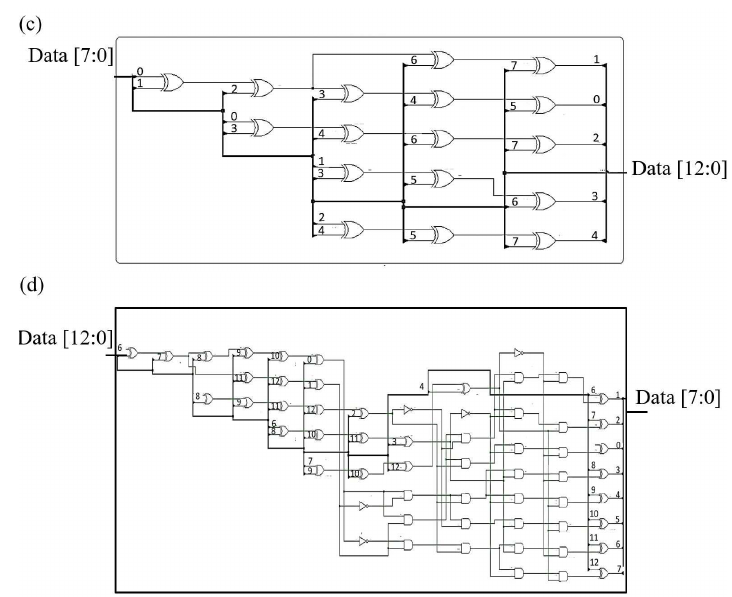
Figure 4. Configured EBRAM: ( a ) the four types of EBRAM; ( b ) the generated 8-channel TMR circuits; ( c ) the generated ECC encode circuits in FPGA; and ( d ) the generated ECC decode circuits in FPGA.